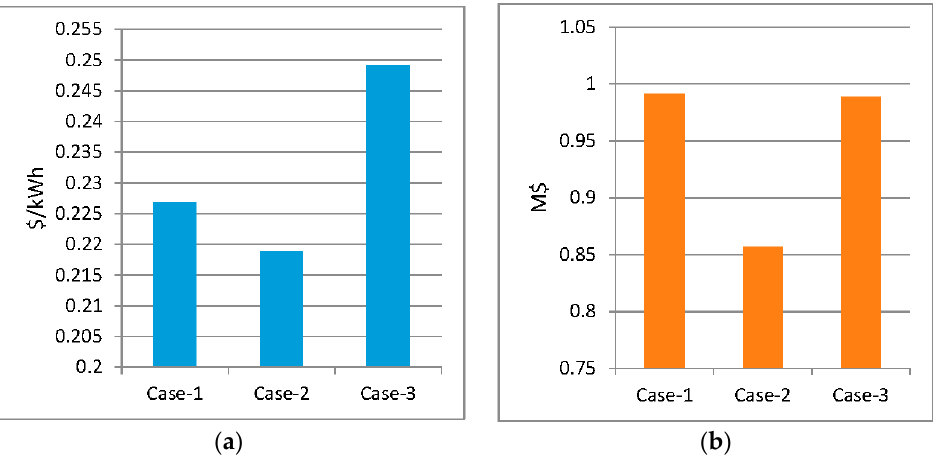
Figure 13. ( a ) Cost of electricity (COE) and ( b ) net present cost (NPC).